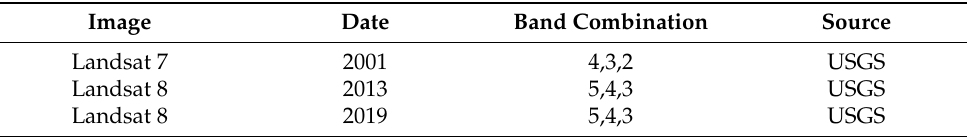
Table 1. Satellite images used and band combinations.